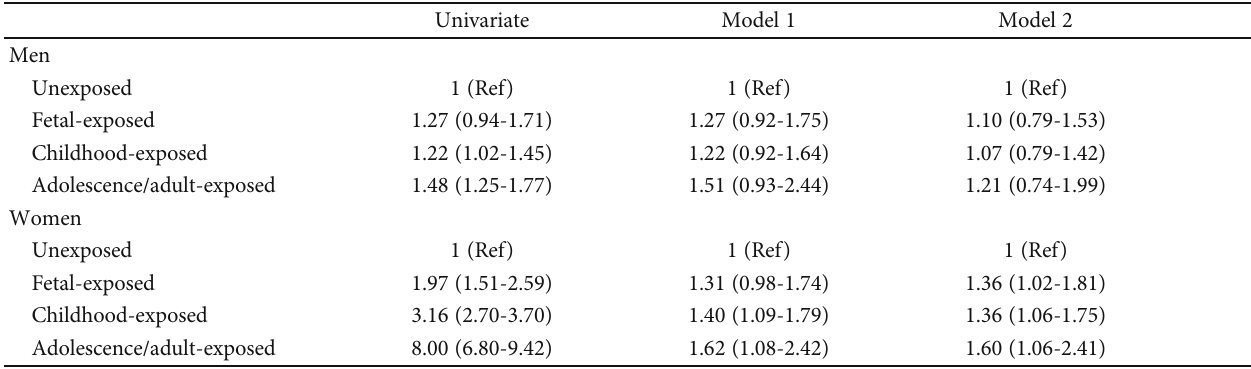
Table 5: Odds ratio (95% con fi dence interval) of metabolic syndrome in relation to di ff erent life stages at famine exposure by the CDS de fi